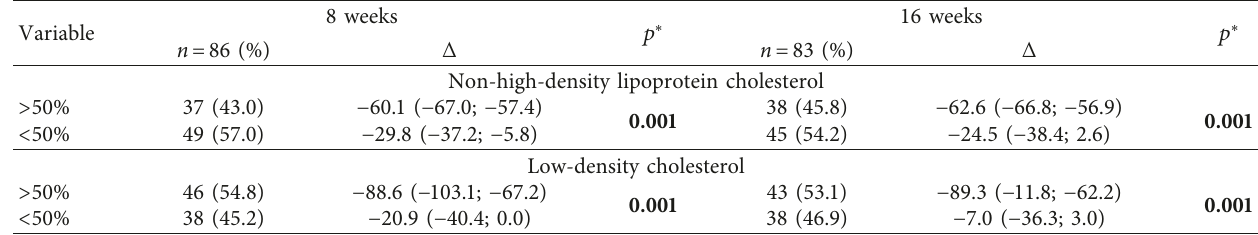
Table 3: Proportion of subjects with > 50% reduction in non-HDL-c and